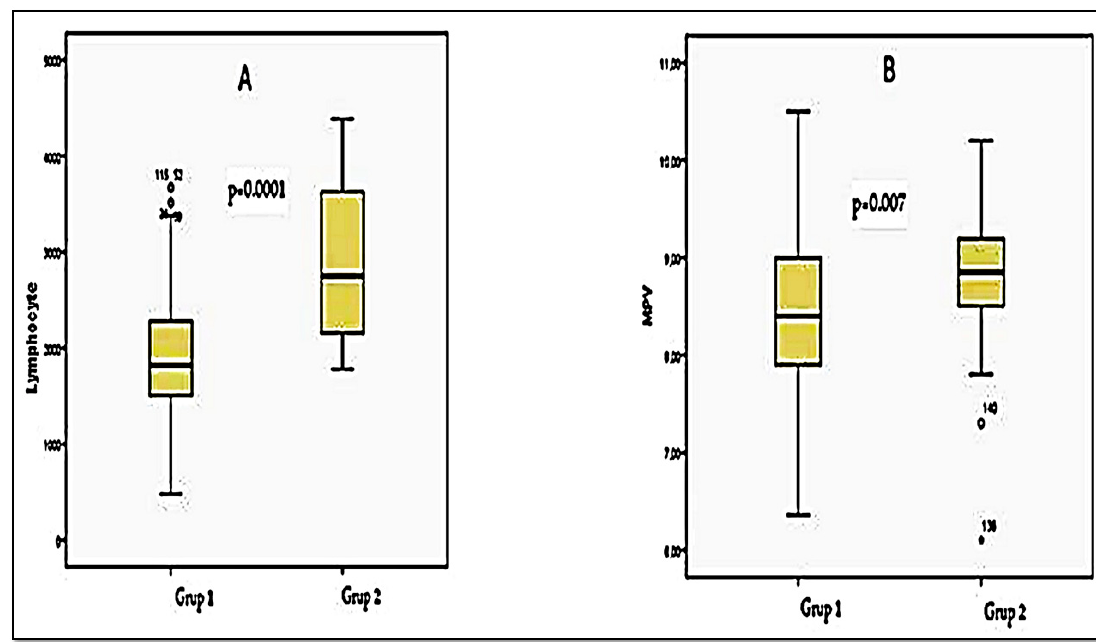
Figure 2. ( A ) The comparison of lymphocyte values in Group 1 (lung cancer patients) and Group 2 (control cases); ( B ) The comparison of MPV (mean platelet volume) values in Group 1 and Group 2. Table 1. Laboratory findings of lung cancer patients (Group 1) and control cases (Group 2).